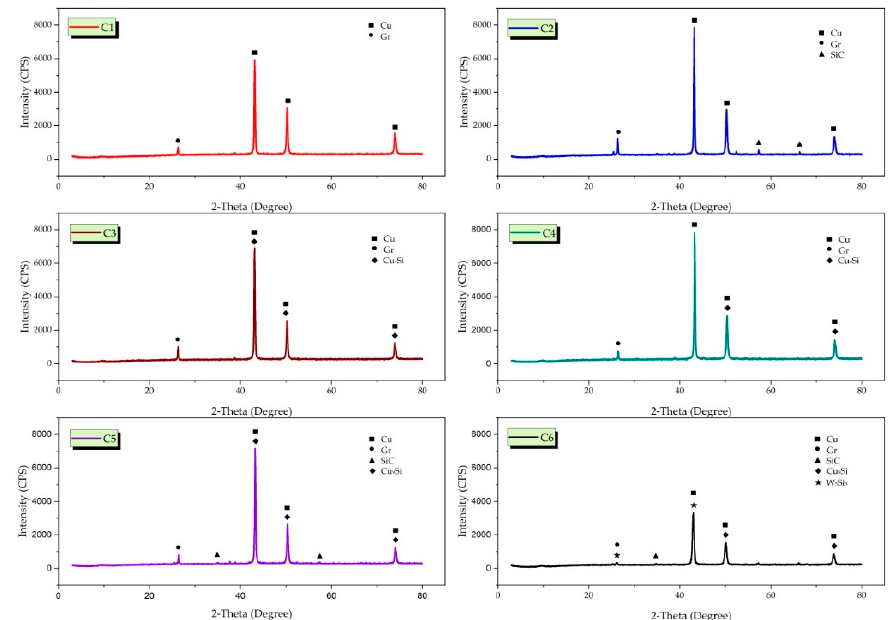
Figure 7. X-RD plots of composite specimens.